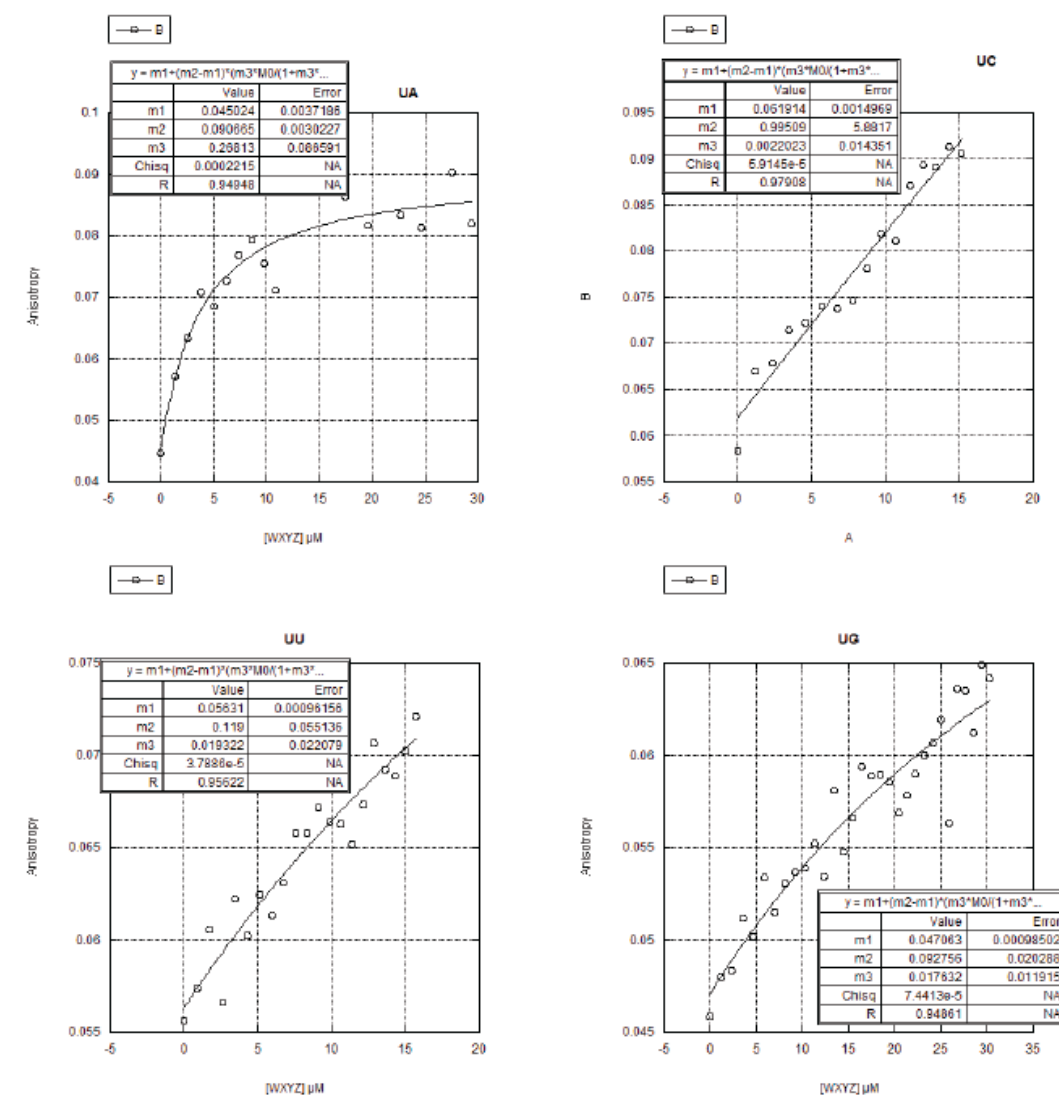
Figure A3. Raw anisotropy data for IGS-tag combinations where the middle nucleotide of the IGS is U. All of these plots show a saturation in polarization as RNA concentration increases.